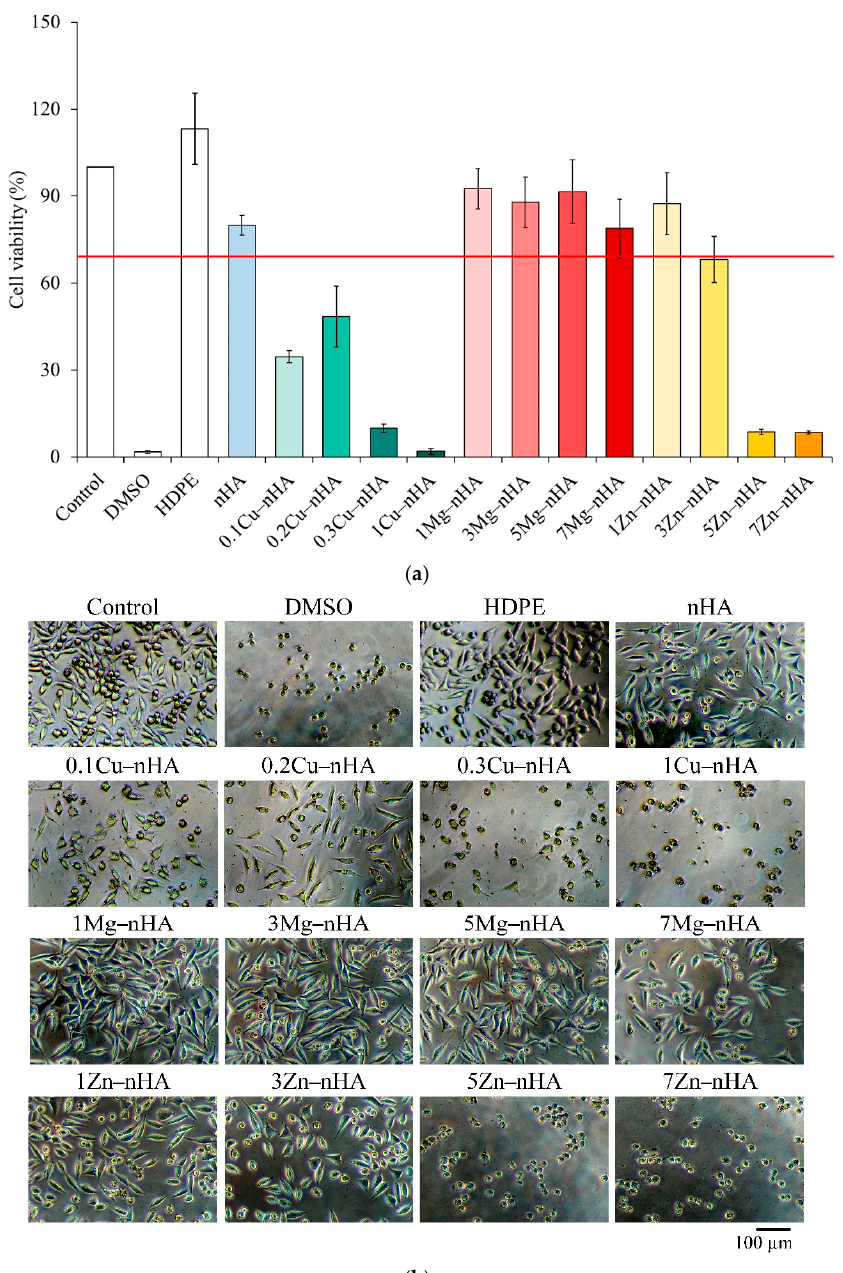
Figure 6. ( a ) Quantitative results of cytotoxicity ( n = 6) after culturing L929 cells with nanoapatite doped with different metallic ions for 1 day; ( b ) qualitative analysis of cytotoxicity. The preparation of metal ion-incorporated nanoapatites with facile synthetic tech- Nanoapatite constitutes the major inorganic components of bones and teeth and niques is a significant topic. These nanoapatites inhibit drug resistance and biofilm for- can thus improve mechanical properties combined with nanotopographic features that mation, especially during open wound repair. Functional nanoapatites with anitbacterial mimic natural bone nanostructures. In this study, we discovered nanoapatite with metal ions, which can be functionalized because of its biocompatibility and effects that inhibit bacterial action. Therefore, the synthesized apatite exhibited antibacterial activity when co- precipitated with Cu 2+ , Mg 2+ , and Zn 2+ , especially in the 0.2Cu − nHA nanoapatite,